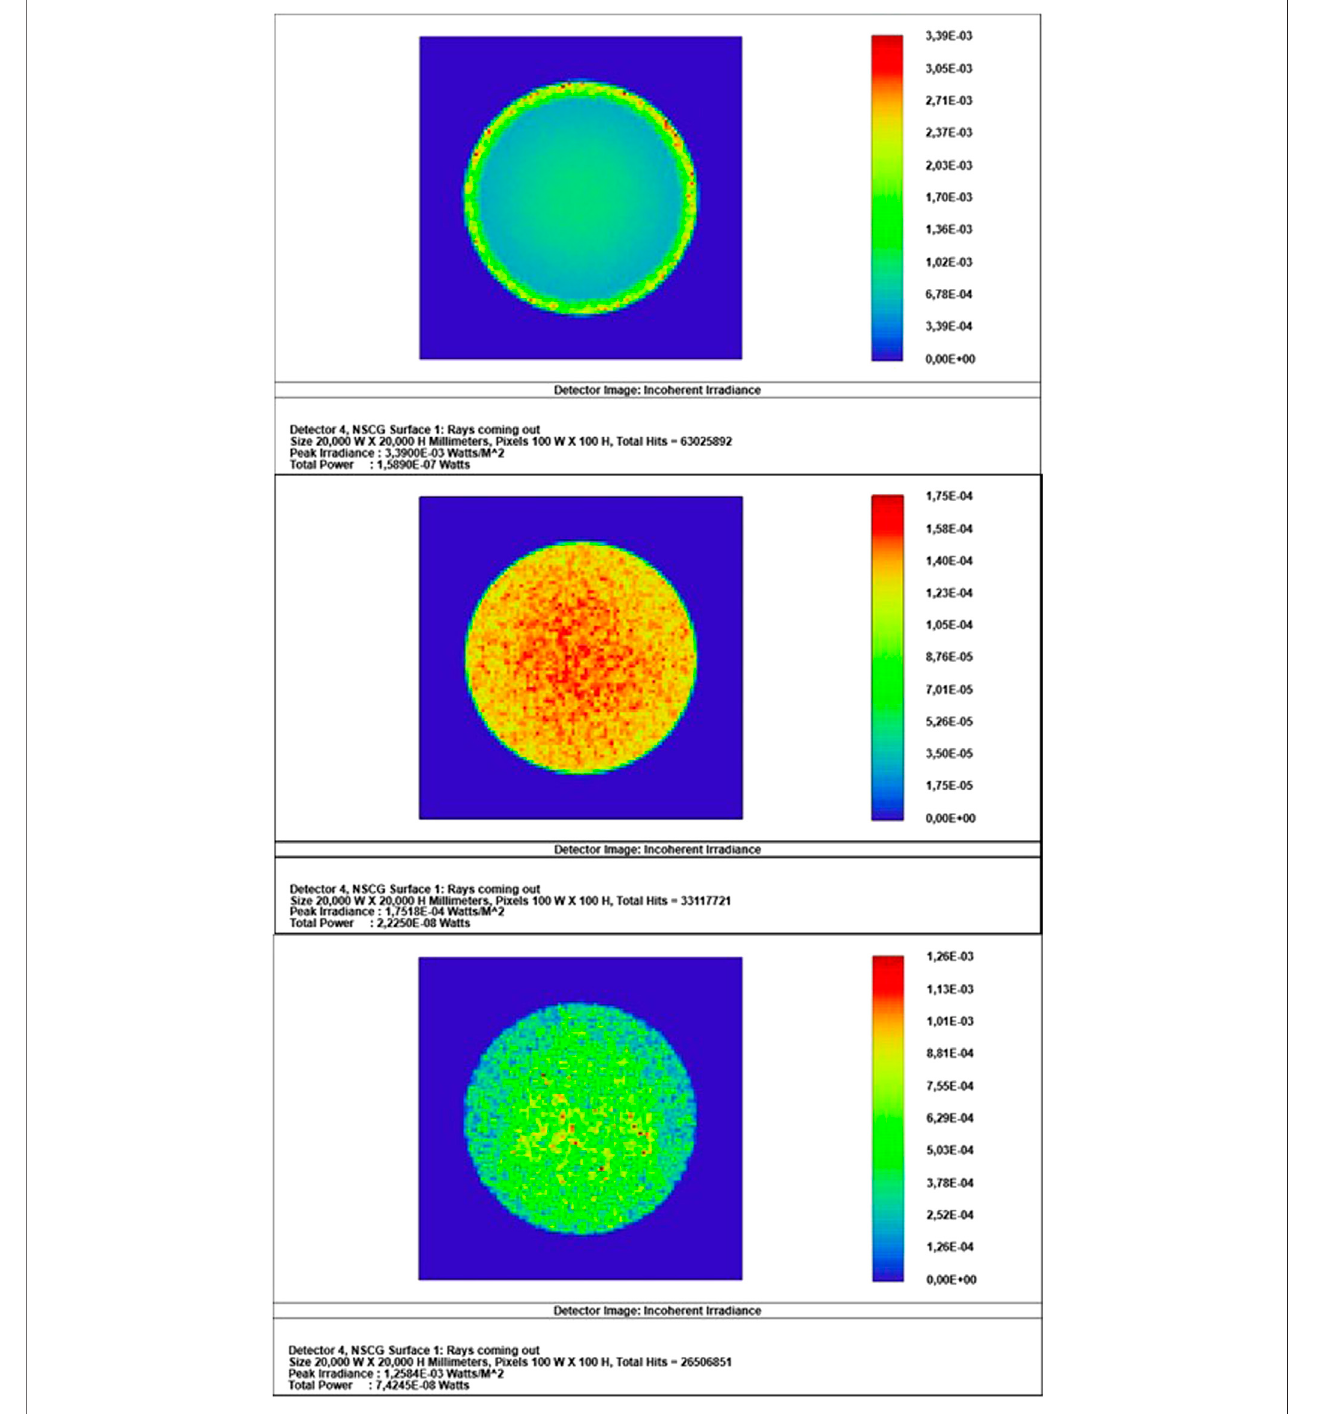
FIGURE 5 | Simulation results of incoherent irradiance distribution of the cavities C1 (top) , C2 (middle) and C3 (bottom) .